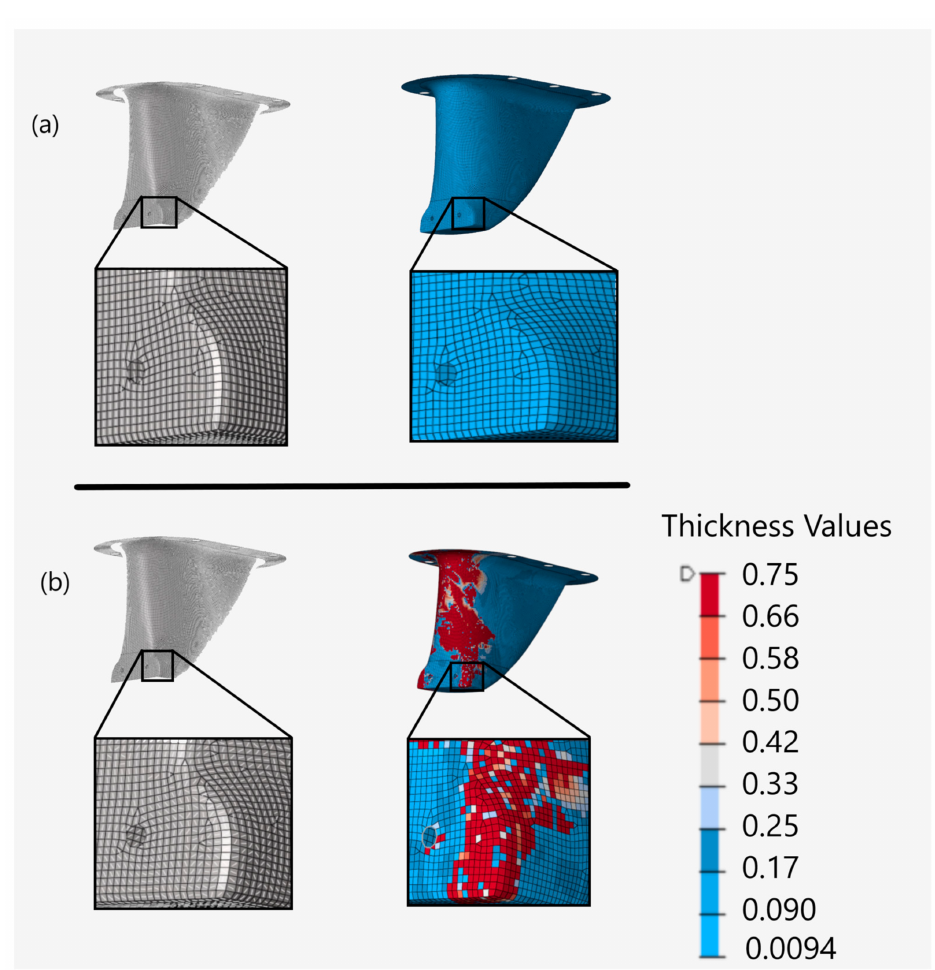
Figure 6. Example of unidirectional fiber angles left and ply thickness right without draping ( a ) and with draping ( b ) for integral